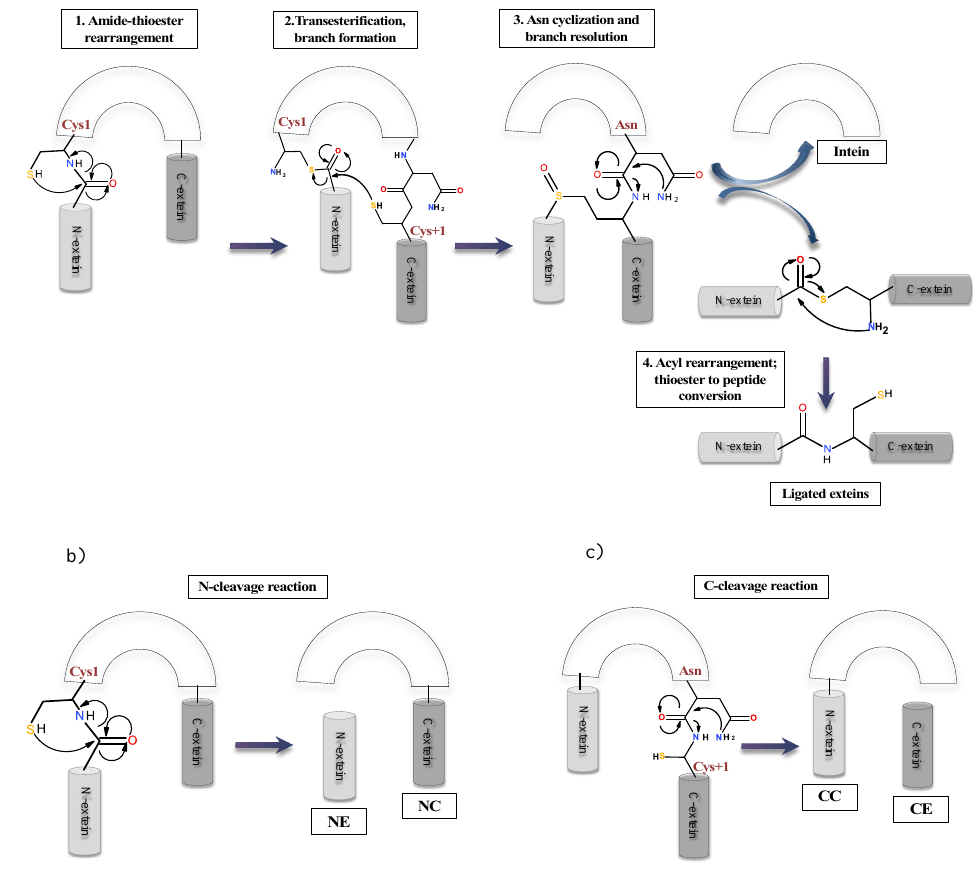
Figure 5. Schematic representation of canonical pathway of intein splicing. ( a ) Intein splicing requires 4 sequential nucleophilic displacement reactions catalysed by Cys1, Cys + 1 and terminal Asn. 1. (N-S / N-O) acyl shift converting the peptide bond of N-terminal splice junction to a (thio)ester linkage. 2. A transesterification reaction to form a branched intermediate. 3. Asn cyclization to resolve the branched intermediate by cleavage of C-terminal splice junction. 4. A second (S-N / O-N) acyl shift to ligate the two extein segments by an amide bond formation; ( b , c ) off-pathways generating cleavage products. NC: N-terminal cleavage products, CC: C-terminal cleavage products, NE: N-extein and CE: C-extein.